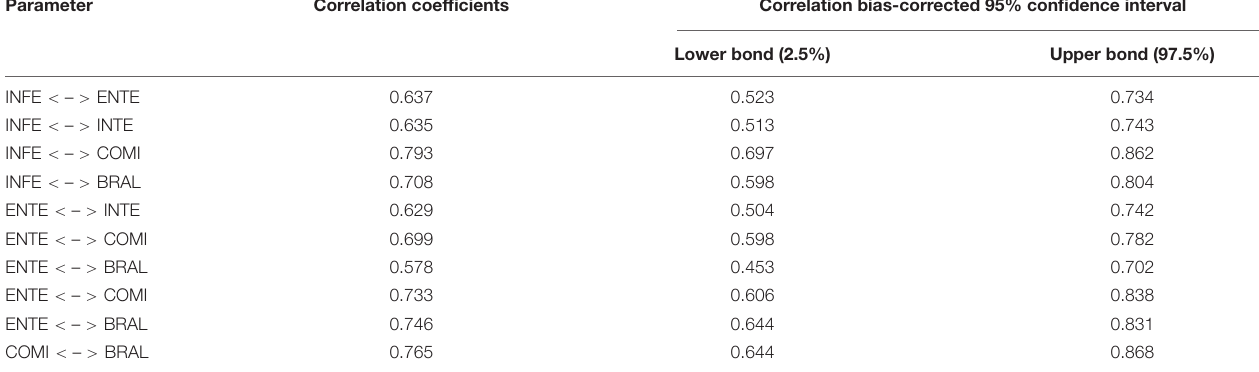
TABLE 3 | Discriminant validity.